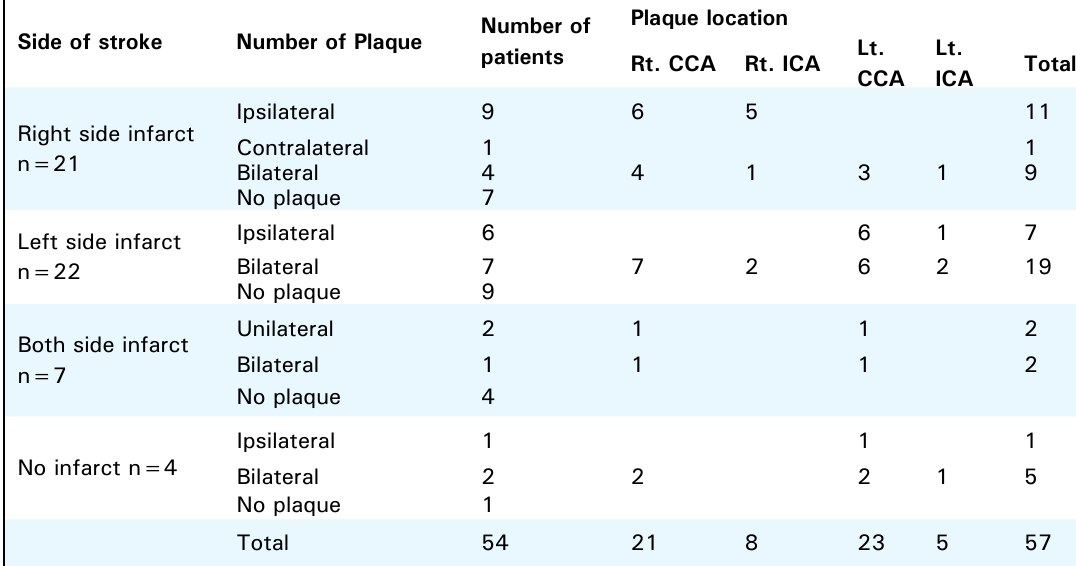
Table 2. The overview of the plaque distribution and